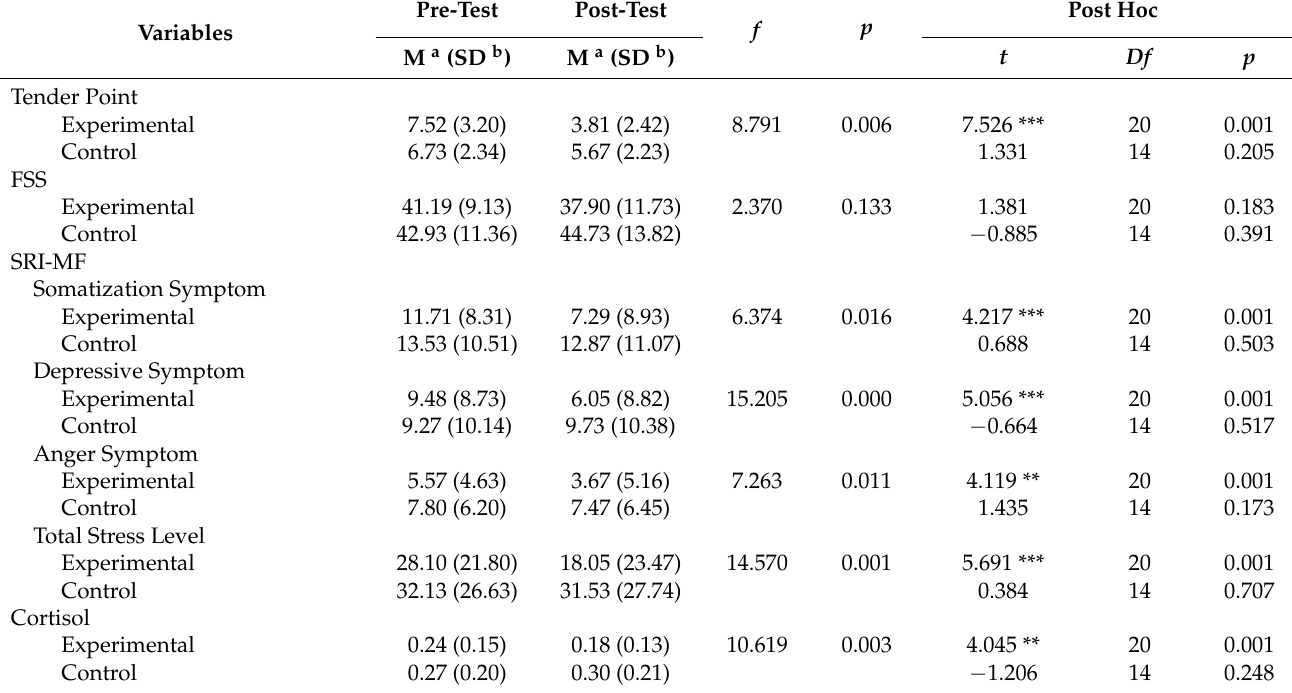
Table 4. Comparison of instruments between and within experimental and control groups in the overall